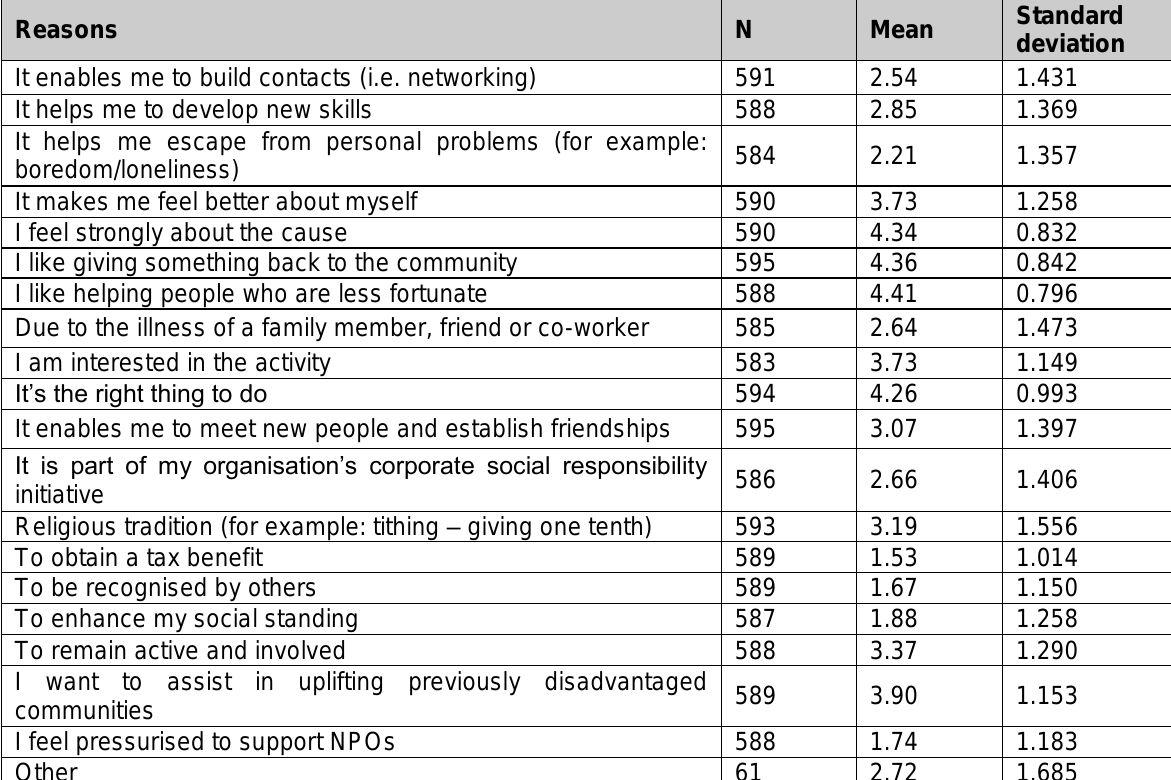
Table 2: Reasons for supporting NPOs